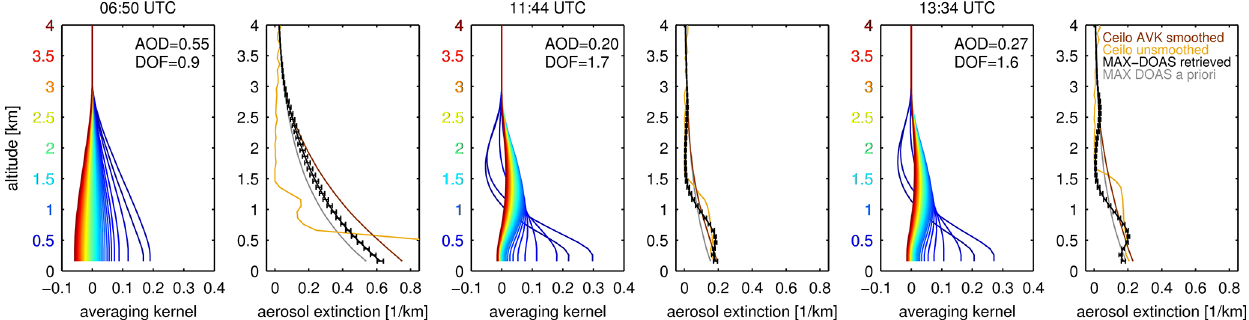
Figure 3. Same as Fig. 2 but for the visible channel (MAX-DOAS: 425–490nm, ceilometer: 470nm).